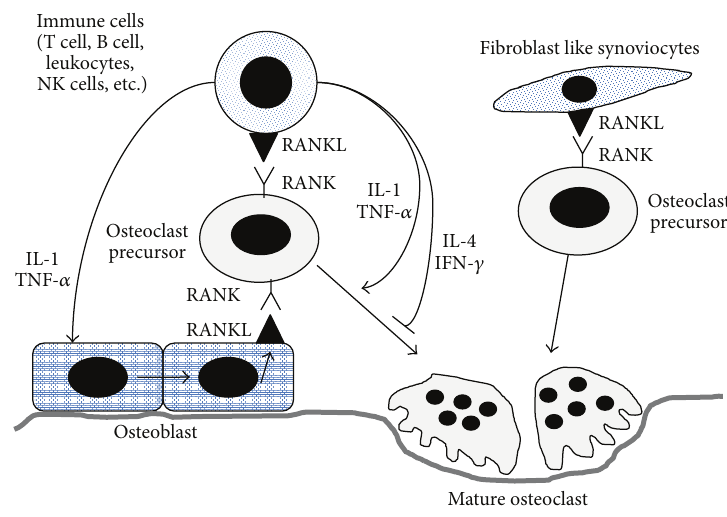
Figure1:Osteoblast-derivedRANKLbindstoRANKonmonocytestodifferentiatethemintomatureosteoclasts.Osteoblast-derivedRANKL